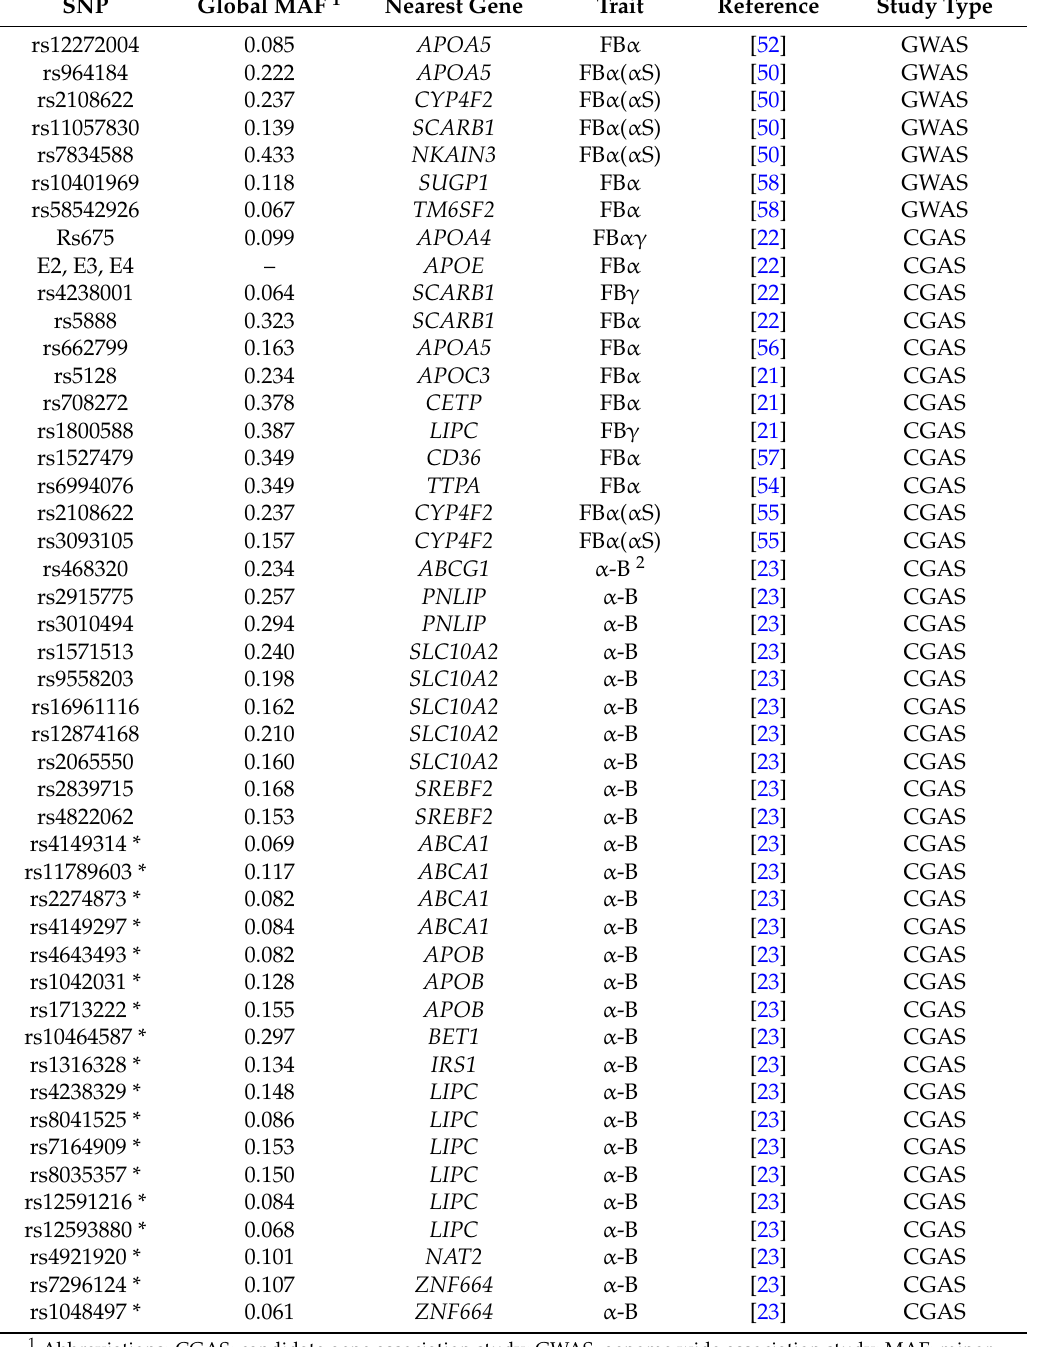
Table 1. Summary of SNPs associated with fasting blood VE concentration or VE